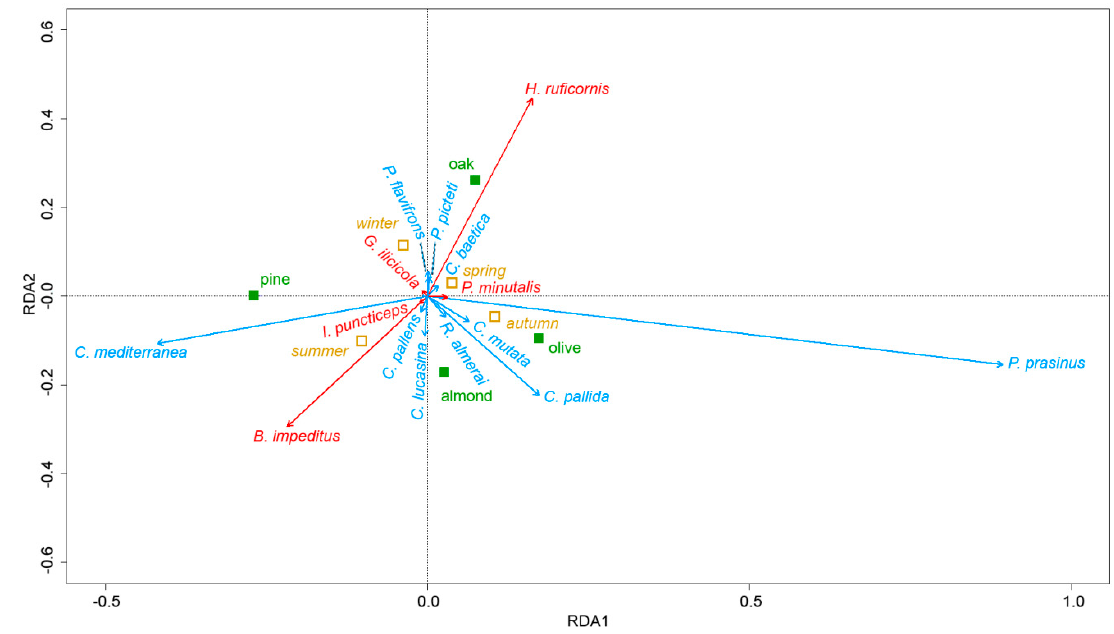
Figure 3. Redundancy analysis (RDA) tri-plot ordination showing variations in the abundance of the parasitoid complex (in red) and chrysopid species community (in blue) with respect to two nominal variables; tree species (in green) and season (in yellow).